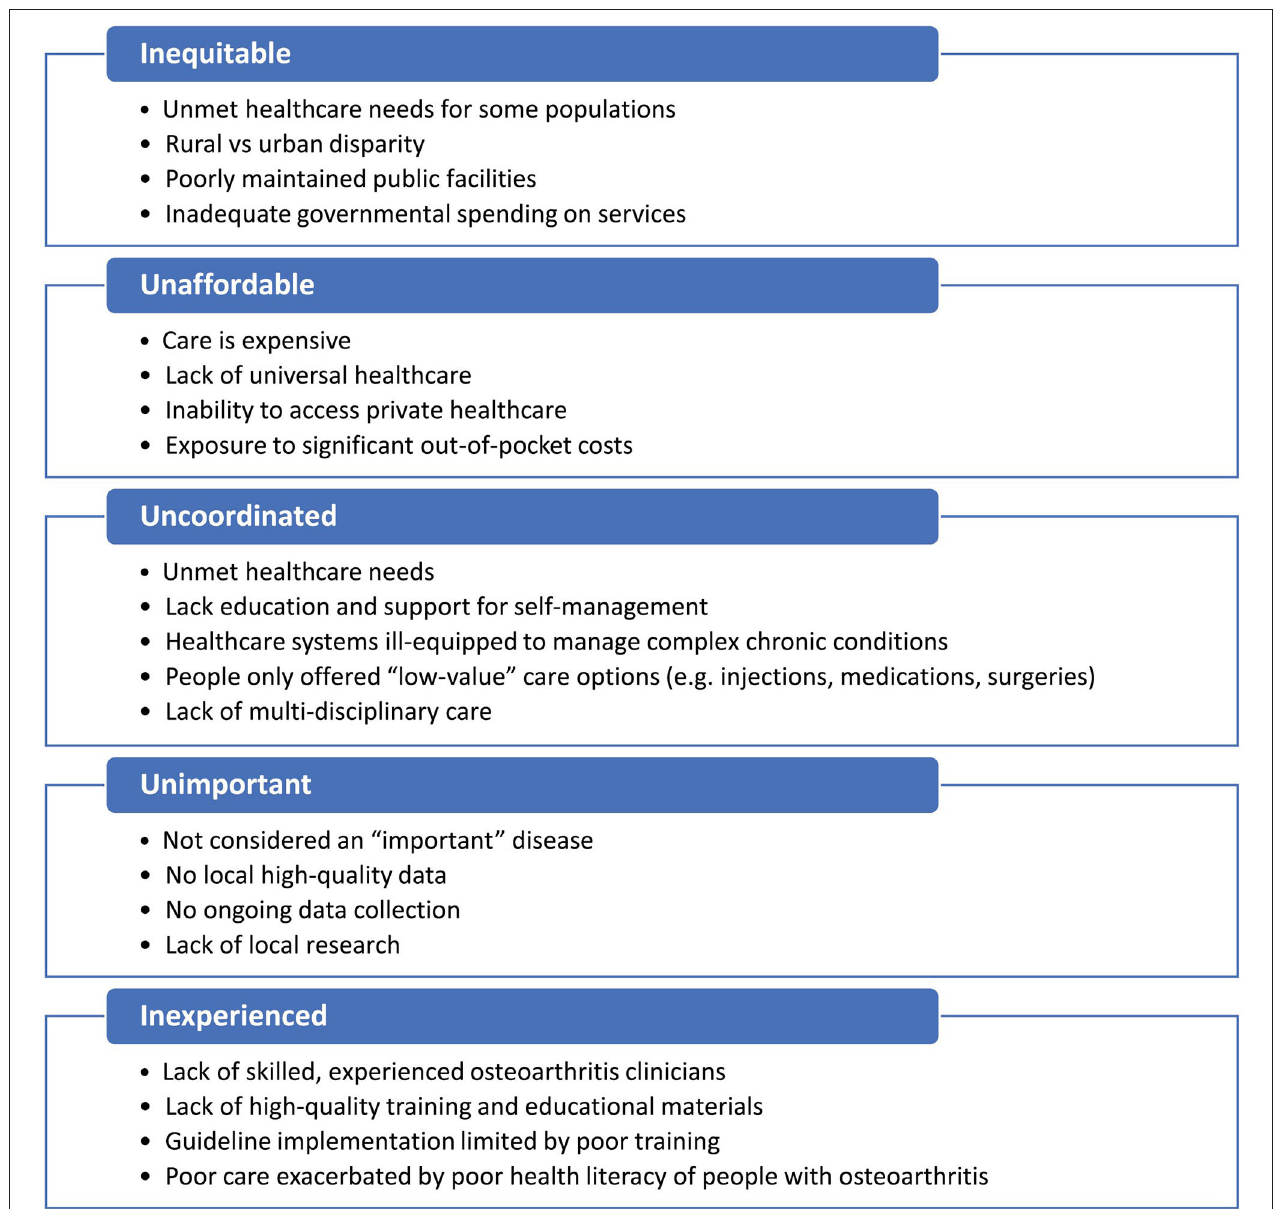
FIGURE 1 | Barriers to high-value osteoarthritis care in Low- and Middle-Income